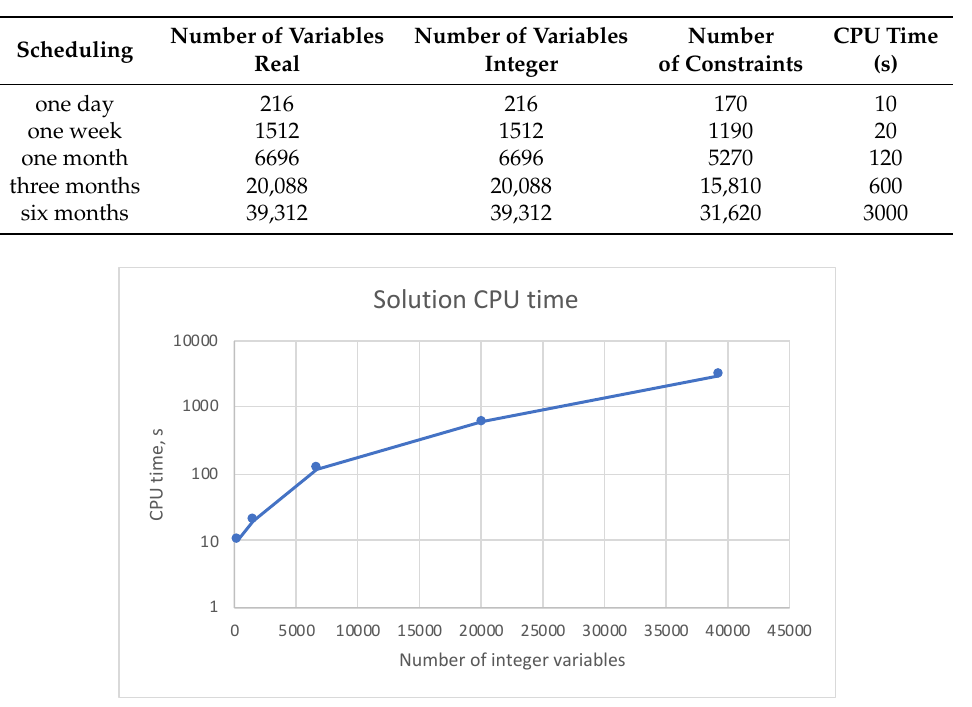
Figure 2. Computational cost, in s, versus number of integer